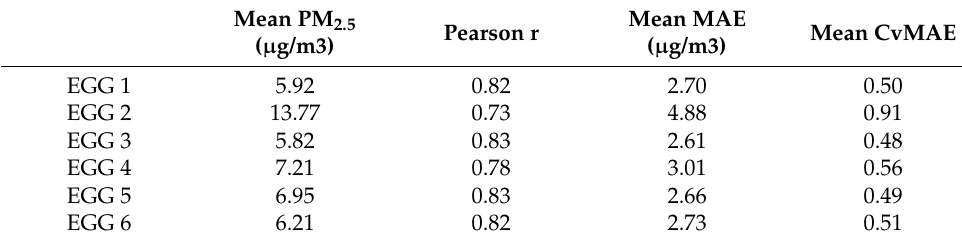
Table 1. The 1-min mean PM 2.5 concentration, the Pearson r , the mean absolute error (MAE), and the coefficient of variation of the mean absolute error (CvMAE) of the six project Air Quality Egg (EGG) lost-cost sensors that were co-located at Kensington Park (Figure 2) prior to the study period. The EGG 4 and EGG 6 sensors were later deployed to the facility inside the ground floor lobby and outside a second-floor window, respectively. However, EGG 6 failed shortly after the beginning of the study period. Mean PM 2.5 Mean MAE Pearson r Mean CvMAE ( µ g/m3) ( µ g/m3) EGG 1 5.92 0.82 2.70 0.50 EGG 2 13.77 0.73 4.88 0.91 EGG 3 5.82 0.83 2.61 0.48 EGG 4 7.21 0.78 EGG